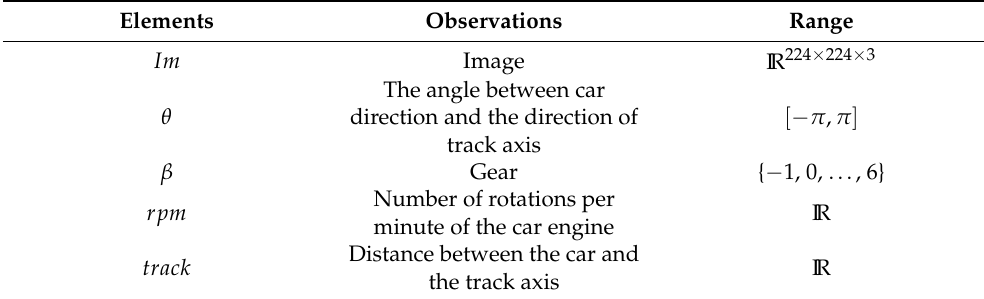
Table 2. Action space of the car. These are the elements that can be controlled in the car. Elements Actions of the Car Range accel Accelerator pedal [0, 1] break Break pedal [0, 1] clutch Clutch pedal [0, 1] gear Gear { − 1, 0, ..., 6} steering Steering wheel angle [ − π , π